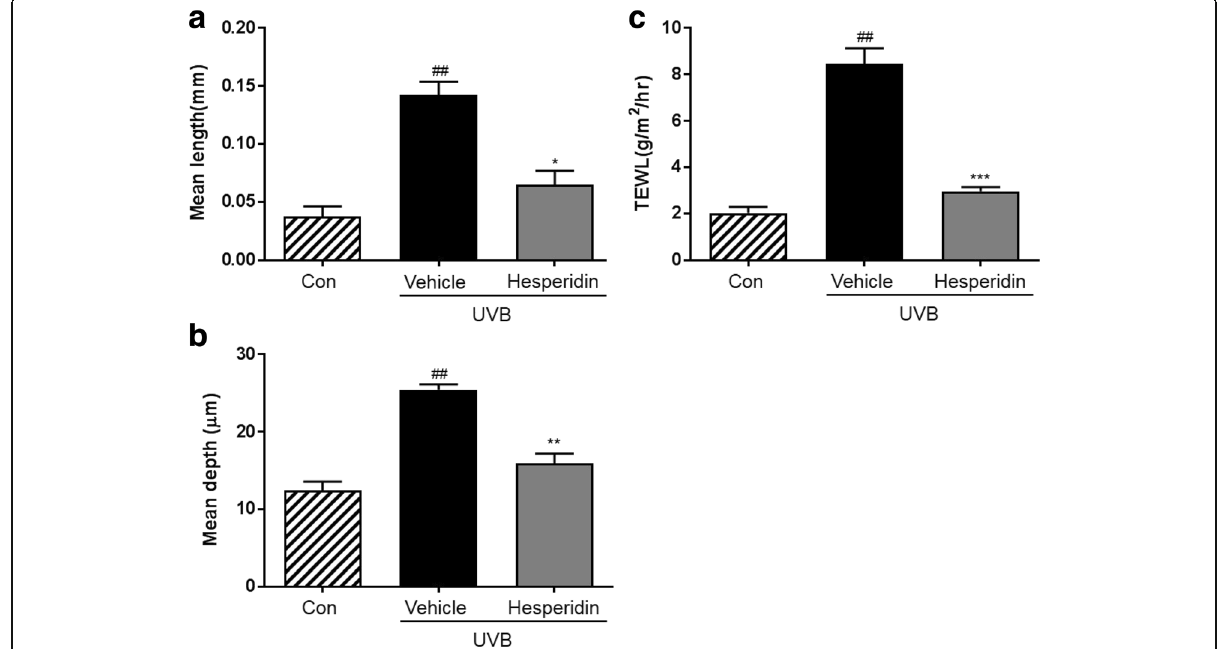
Fig. 2 Effects of hesperidin on the UVB-induced wrinkle formation in hairless mice and TEWL. Effects of hesperidin on the ( a ) mean length and ( b ) mean depth of skin wrinkles, and ( c ) TEWL. ## P < 0.01 significant difference from control and * P < 0.05, ** P < 0.01, and *** P < 0.001 significant difference from UVB/vehicle